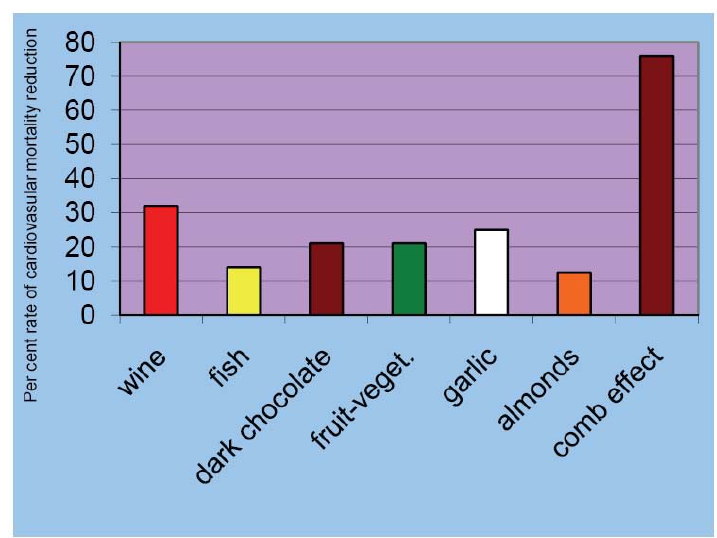
Fig. 4 Reduction rate of cardiovascular mortality after polymeal